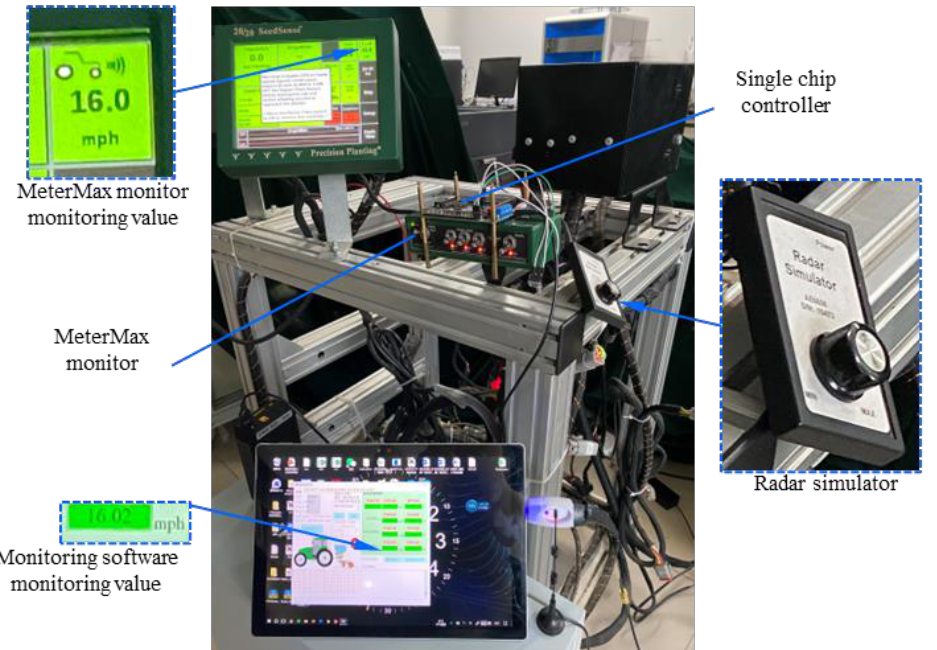
Figure 5. Radar speed monitoring comparison test.